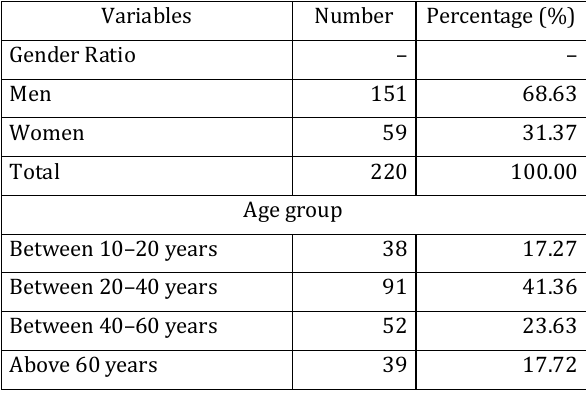
Table 4. Demographic features of